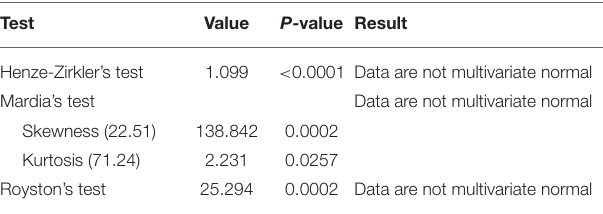
TABLE 1 | Multivariate normality